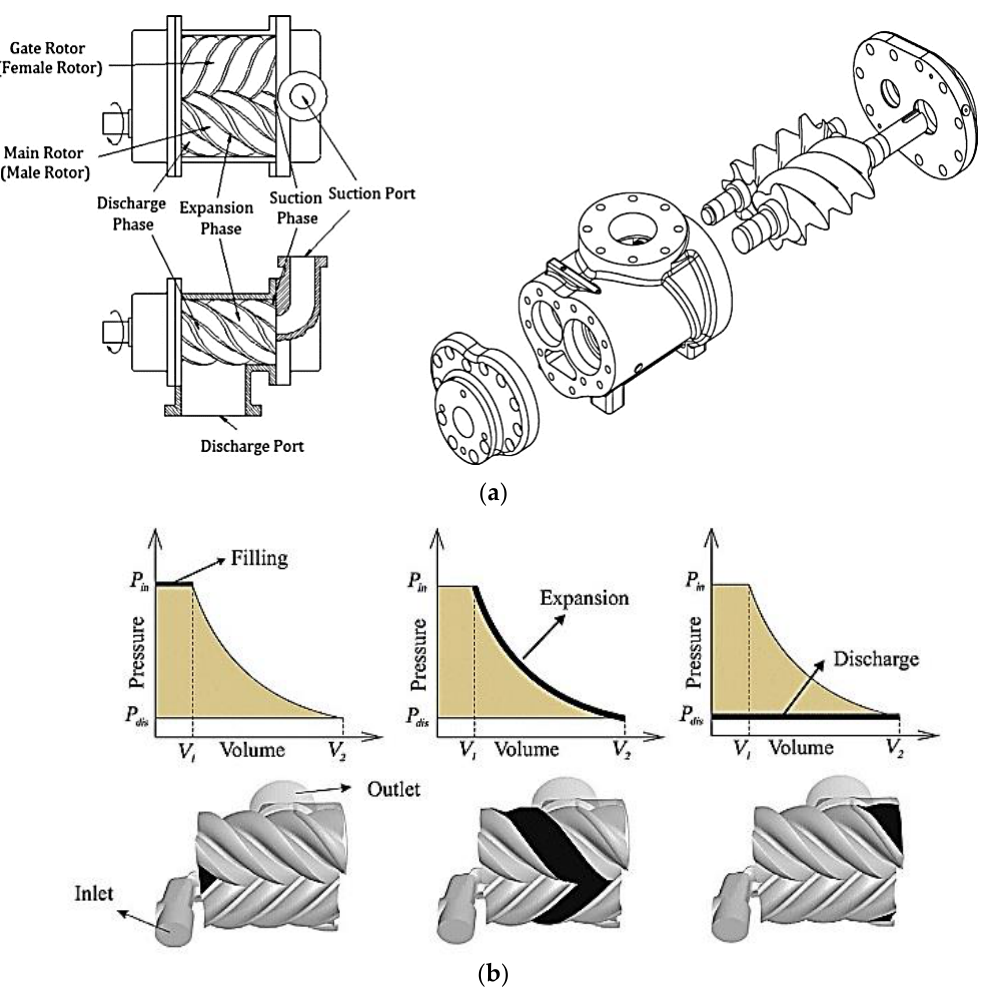
Figure 13. Two-phase twin screw expander, with architecture ( a ) [12] and principle of operation ( b ) [ Error! Reference source not found. ].